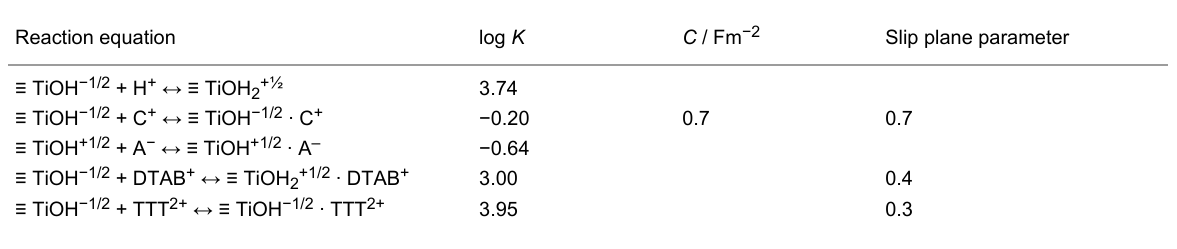
Table 2: Surface complexation parameters for a tentative description of the electro-kinetic data. TTT is an acronym for 12-2-12. The slip plane param- eter is the relation between the slip plane distance and the Debye length. A value of zero would mean that the slip plane coincides with the head-end of the diffuse layer. A value of 0.5 means that the slip plane is at half the Debye length for the respective ionic strength of the 1:1 electrolyte. Here, this concentration is 1 mM and the Debye length at 25 °C is 9.6